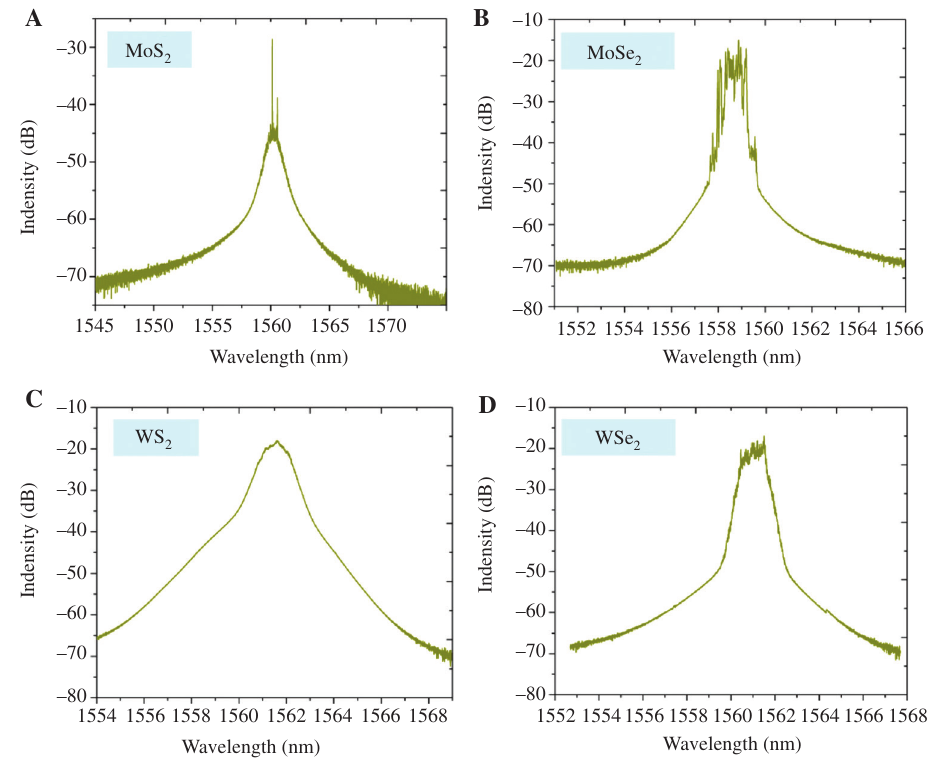
Figure 4: Q-switched spectra enabled by TMD-based SAs. (A) MoS , (B) MoSe , (C) WS , and (D) WSe . Reproduced with permission from Ref. [84]. Copyright 2015 OSA 2 2 2 2